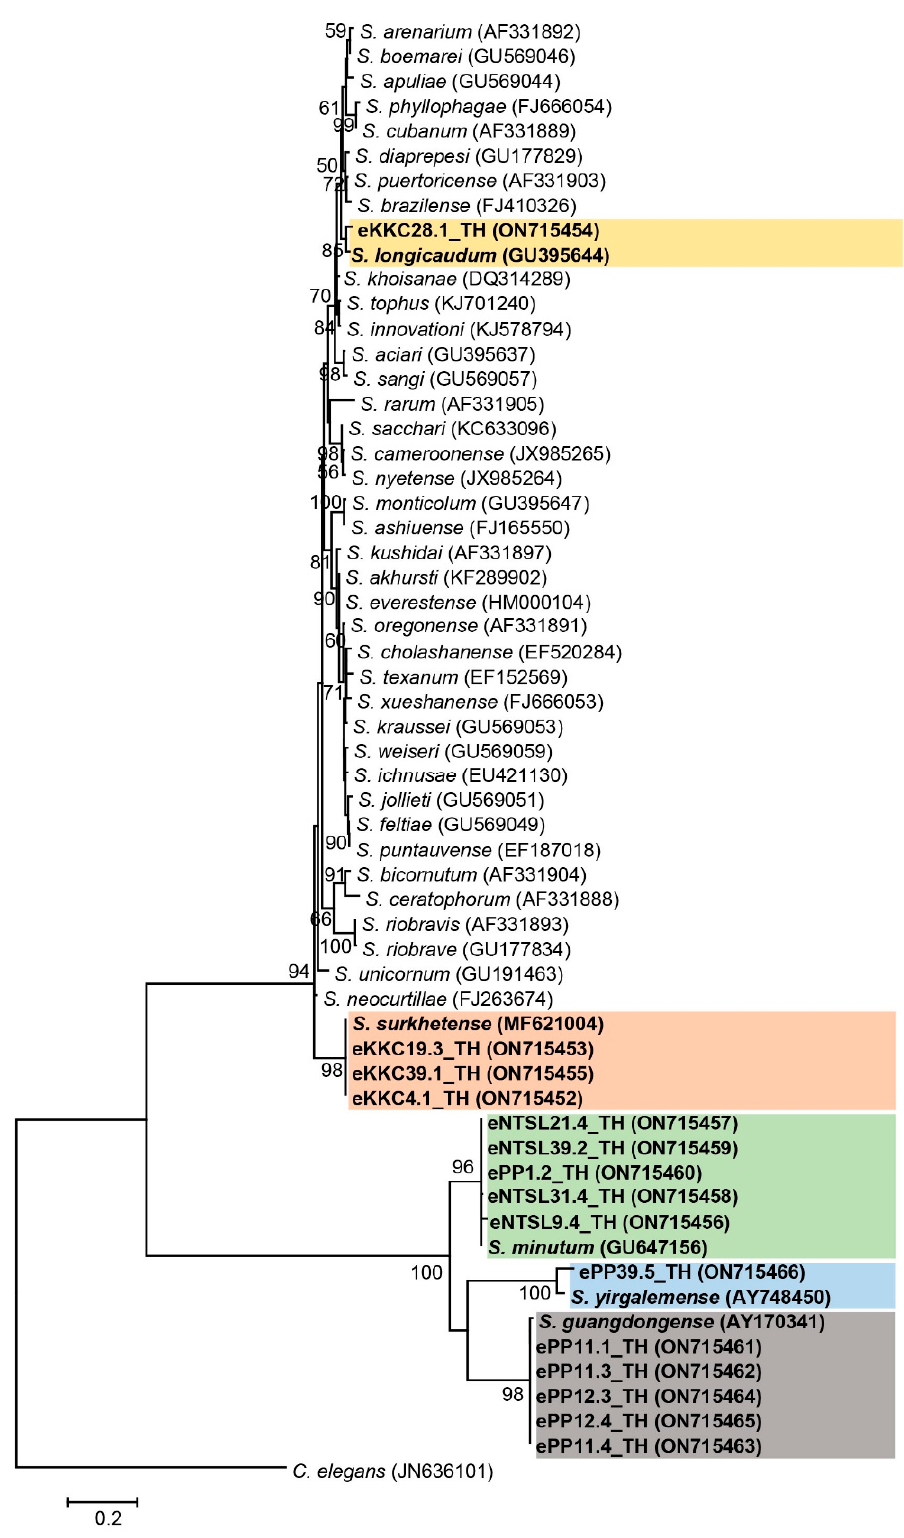
Figure 3. Maximum likelihood tree constructed based on a partial sequence of 28S rDNA (633 bp) of Steinernema nematodes.